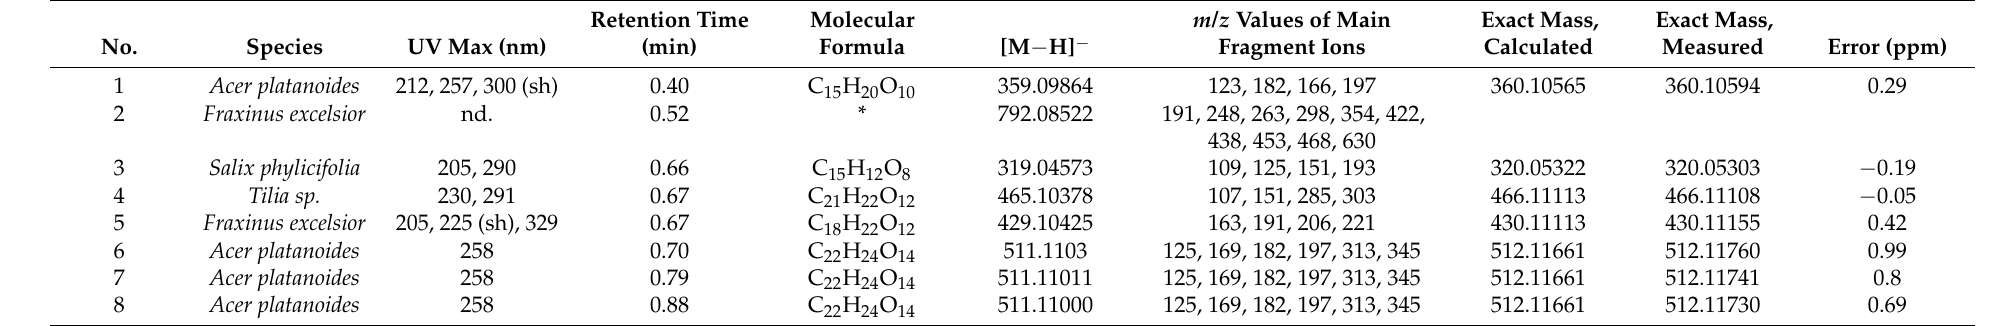
Table 2. Chromatographic, UV, and mass spectral data of the species-specific markers obtained from the